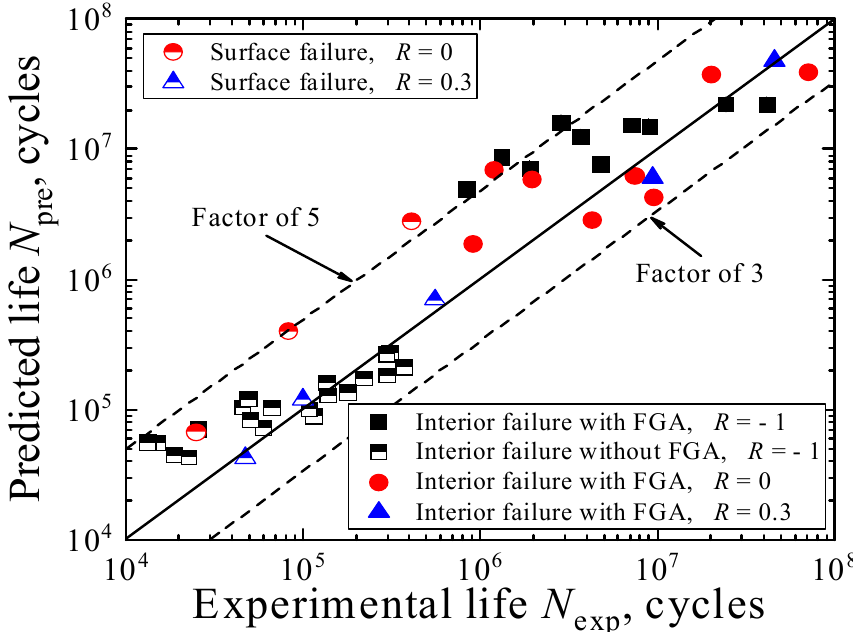
Figure 9. Comparison of predicted life and experimental life.